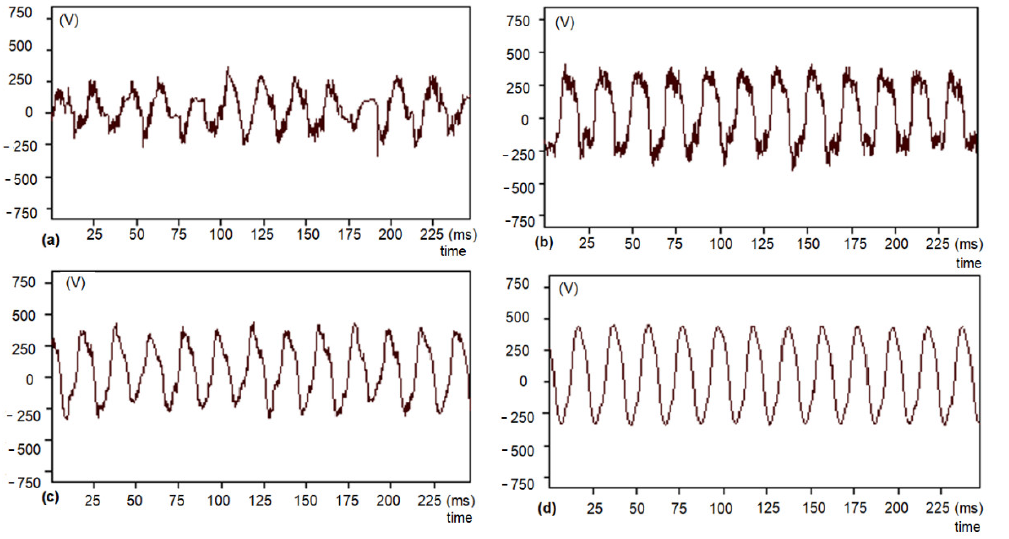
Figure 1. The shape of the arc voltage curve: ( a ) arc ignition start; ( b ) smelting scrap; ( c ) the main phase of melting the scrap; ( d ) final stage of smelting [31].